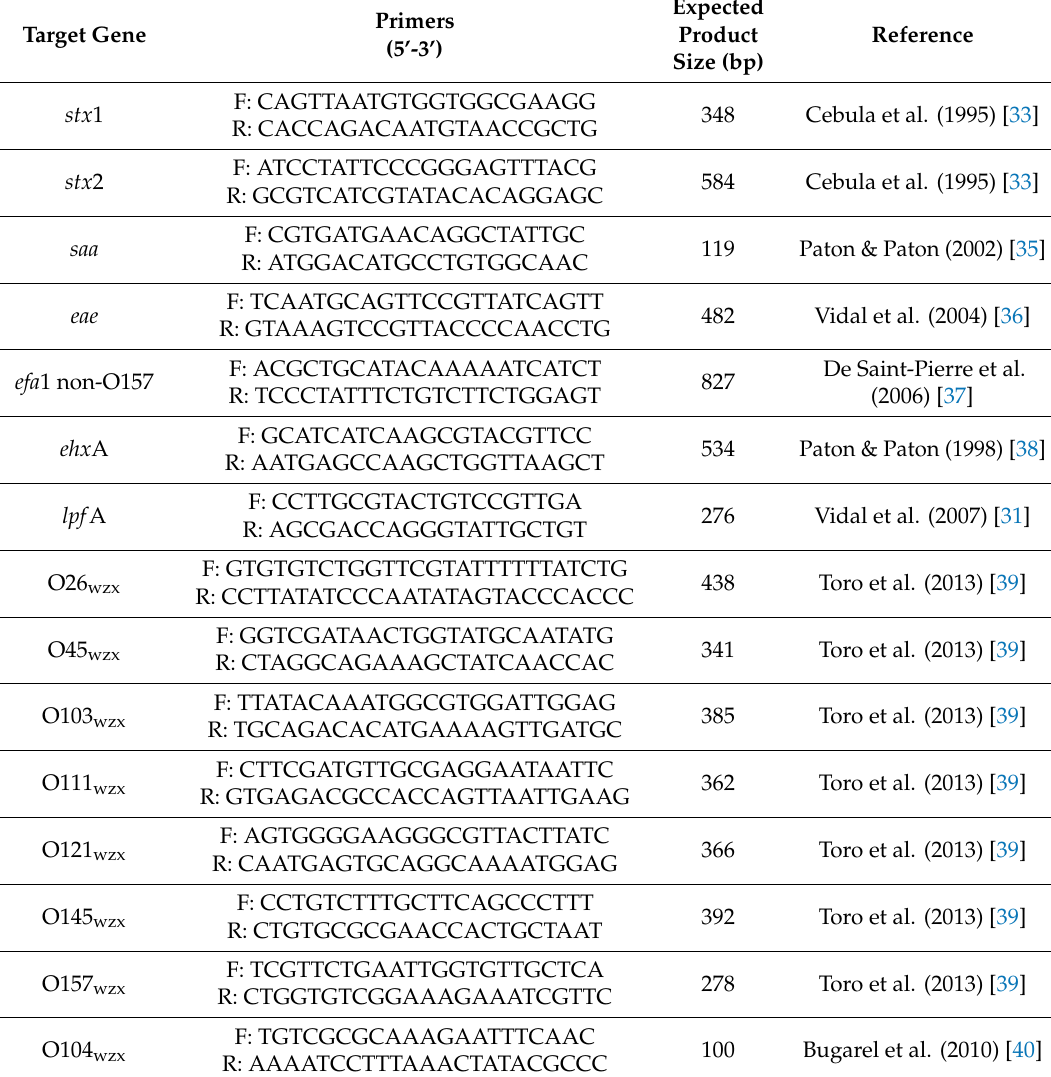
Table 1. Oligonucleotide primer sequences for virulence and O-antigen processing genes, expected product size, and